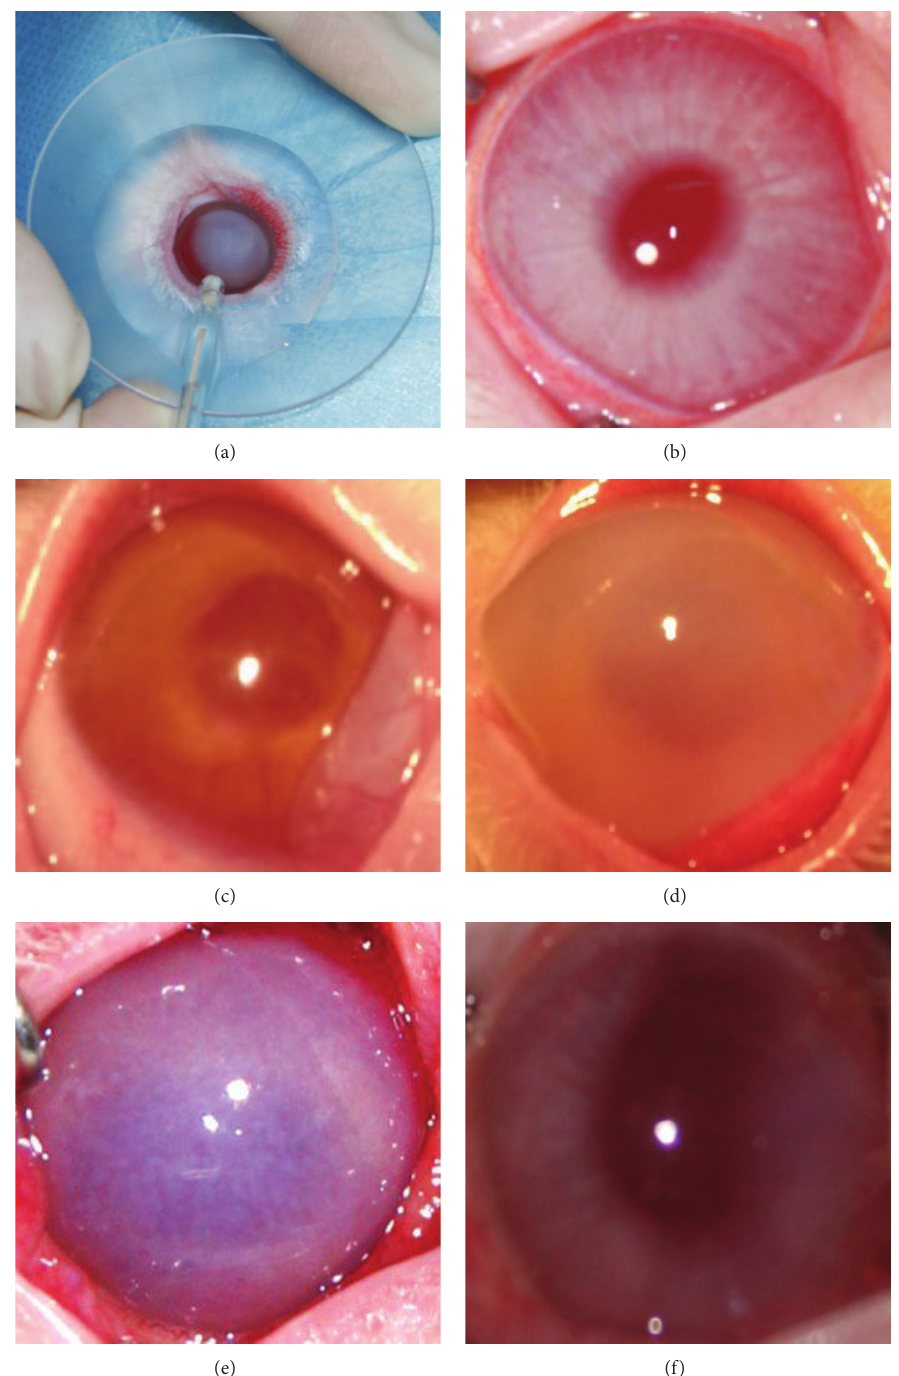
Figure 1: Anterior segment photographs. (a) RI experiment cathode electrode and the eyecup. The cup is placed around eye cornea, and Ag/AgCl electrode is inserted into the eyecup to provide the cathode current for RI experiments. (b) The normal rabbit eye with smooth and transparent cornea, and transparent anterior chamber in the control group. (c) Immediate image after anterior chamber iron foreign body model. The anterior chamber was brown, and oozing around the pupil was observed. (d) 24 h after anterior iron foreign body model, there were conjunctival hyperemia, corneal edema, large bullous keratopathy, and rust-colored pigmentation, and the anterior chamber was brown. (e) Six days after modeling with 0mA current RI. (f) Six days after modeling with 0.4 mA current